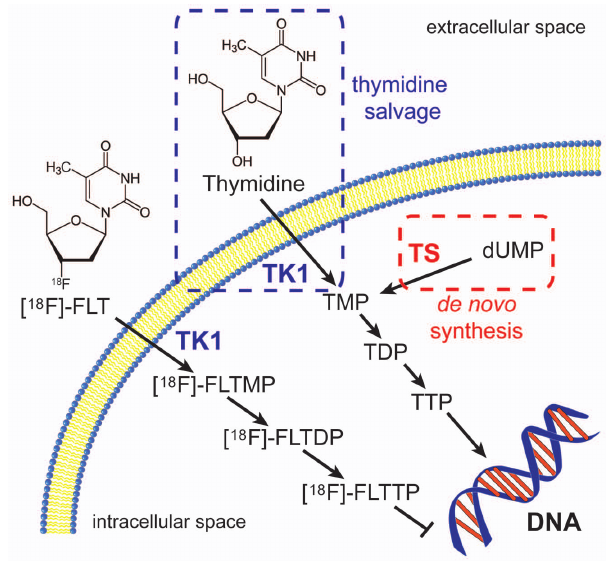
Figure 1. Thymidine salvage and denovo synthesis pathways. In thymidine salvage, thymidine is transported across the cell membrane and phosphorylated by TK1 into thymidine monophosphate (TMP). The thymidine is further phosphorylated into thymidine diphosphate (TDP) and thymidine triphosphate (TTP) and then incorporated into DNA. Alternatively, using the de novo synthesis pathway, deoxyuridine monophosphate (dUMP) is converted to TMP by TS which can then be further phosphorylated and incorporated into DNA. Similarly to thymidine, [ 18 F]-FLT is transported into the cell and phosphorylated into [ 18 F]-FLT monophosphate ([ 18 F]-FLTMP) and trapped by TK1. [ 18 F]-FLTMP can be further phosphorylated into [ 18 F]- FLT diphosphate ([ 18 F]-FLTDP) and [ 18 F]-FLT triphosphate ([ 18 F]-FLTTP), however, due to the substitution of OH with 18 F in the 5-prime position, [ 18 F]-FLTTP is not incorporated into the DNA.